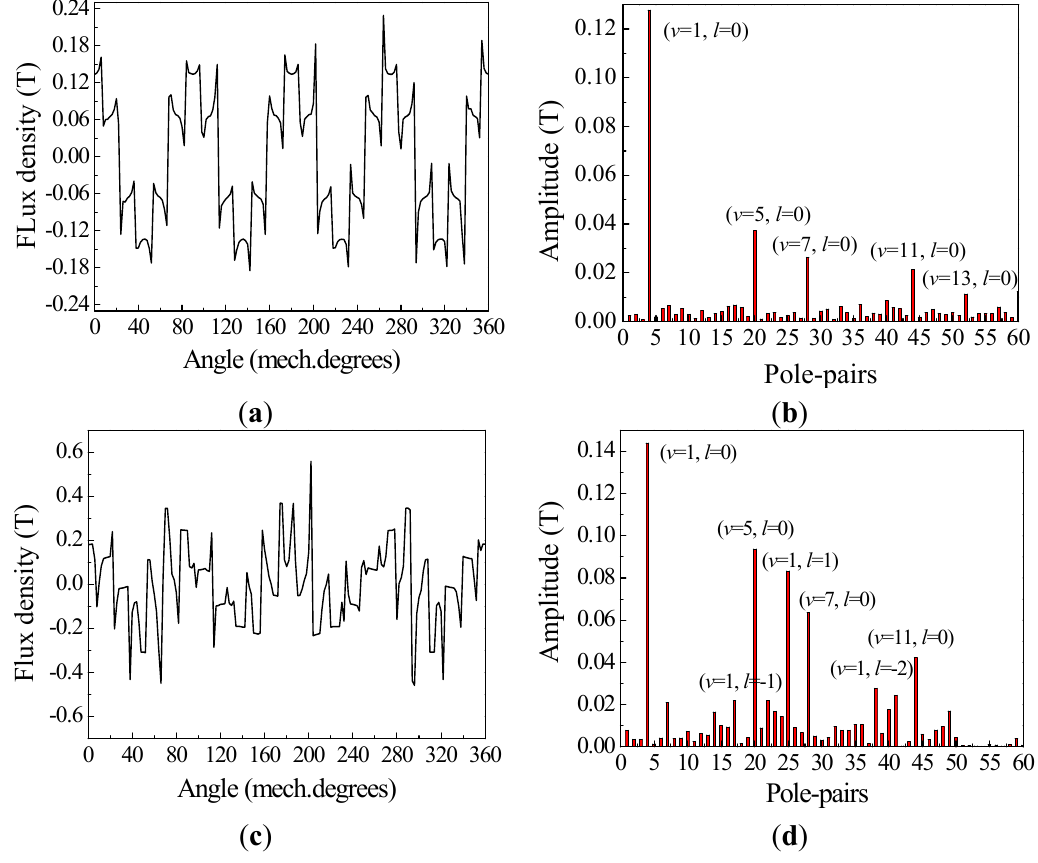
Figure 4. Axial flux density waveforms due to the stator winding, in the air gap adjacent to the stator and corresponding space harmonic spectra: ( a ) axial flux density waveform without the modulating ring rotor; ( b ) the space harmonic spectrum without the modulating ring rotor; ( c ) axial flux density waveform with the modulating ring rotor; and ( d ) the space harmonic spectrum with the modulating ring rotor.